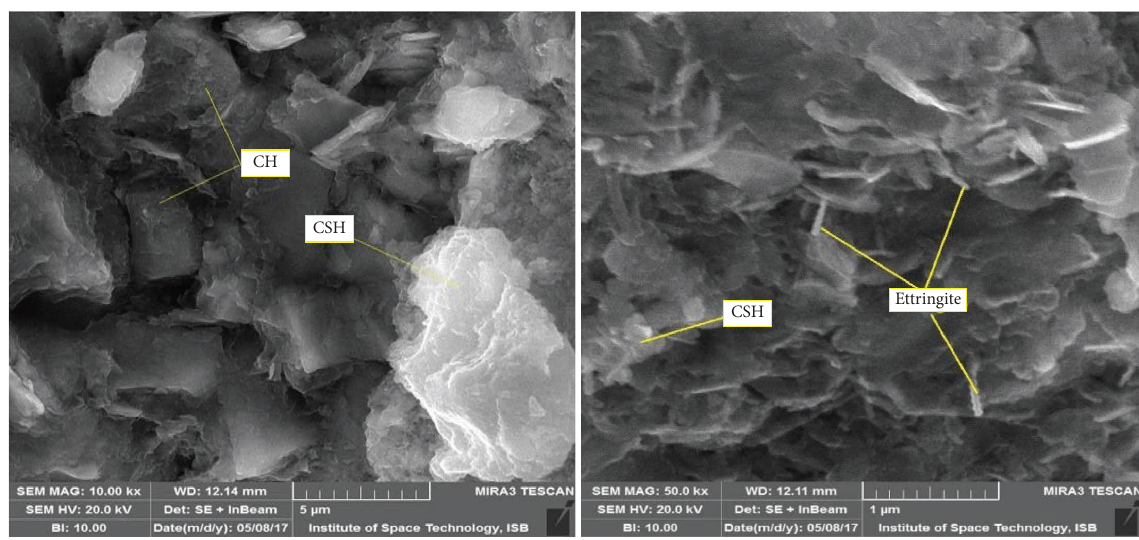
Figure 10: SEM of the RCASCC-100